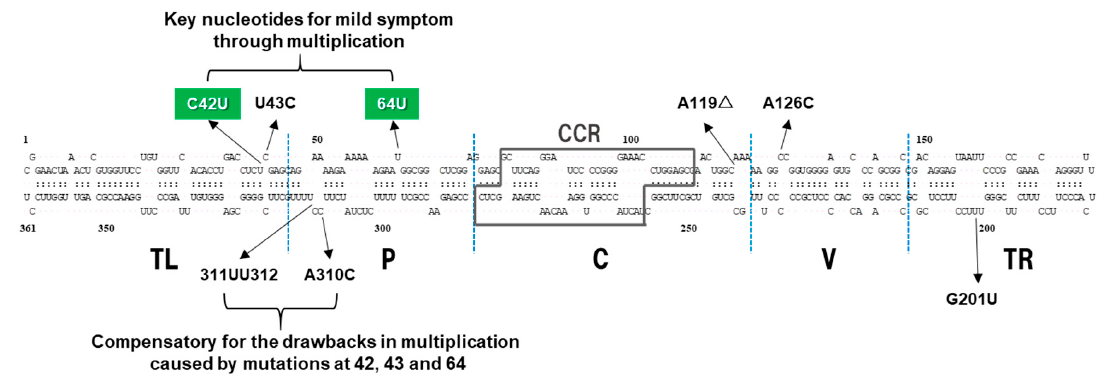
Figure 6. Proposed molecular mechanism of key nucleotides causing mild symptoms of PSTVd-D wt in tomato. The structural / functional domains of PSTVd: Terminal left (TL), Pathogenicity (P), Central (C), Variable (V), and Terminal right (TR), are delimited by the vertical dotted lines and are named accordingly. Boxed sequences indicate central conserved region (CCR). Positions of nine mutations are indicated by arrows, and those in green box indicate key nucleotides identified in this experiment.